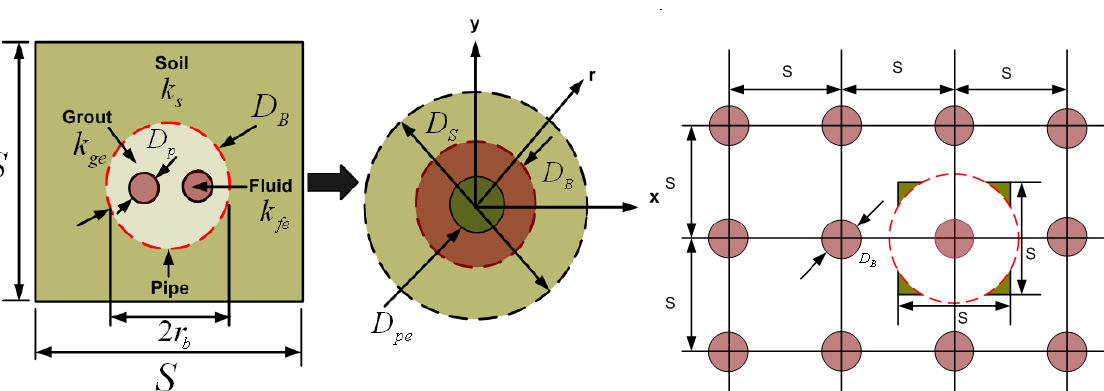
Figure 3. Transformation of a square domain to an equivalent concentric domain.